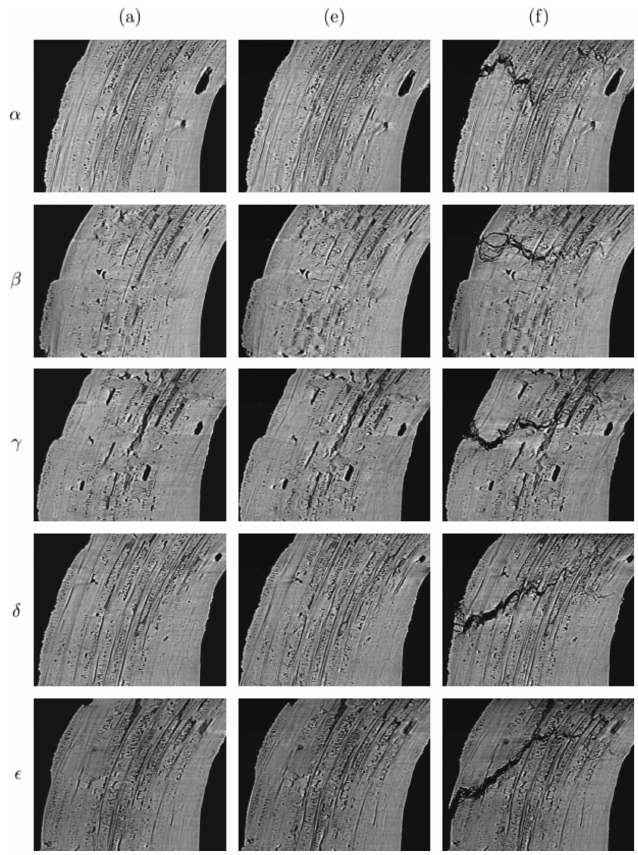
Figure 13 Crack path for the high-temperature test for slices taken every 630 m m (the Greek letters correspond to the slice positions as plotted in Fig. 5). ( a ) Initial state. ( e ) At last step before failure. ( f ) After